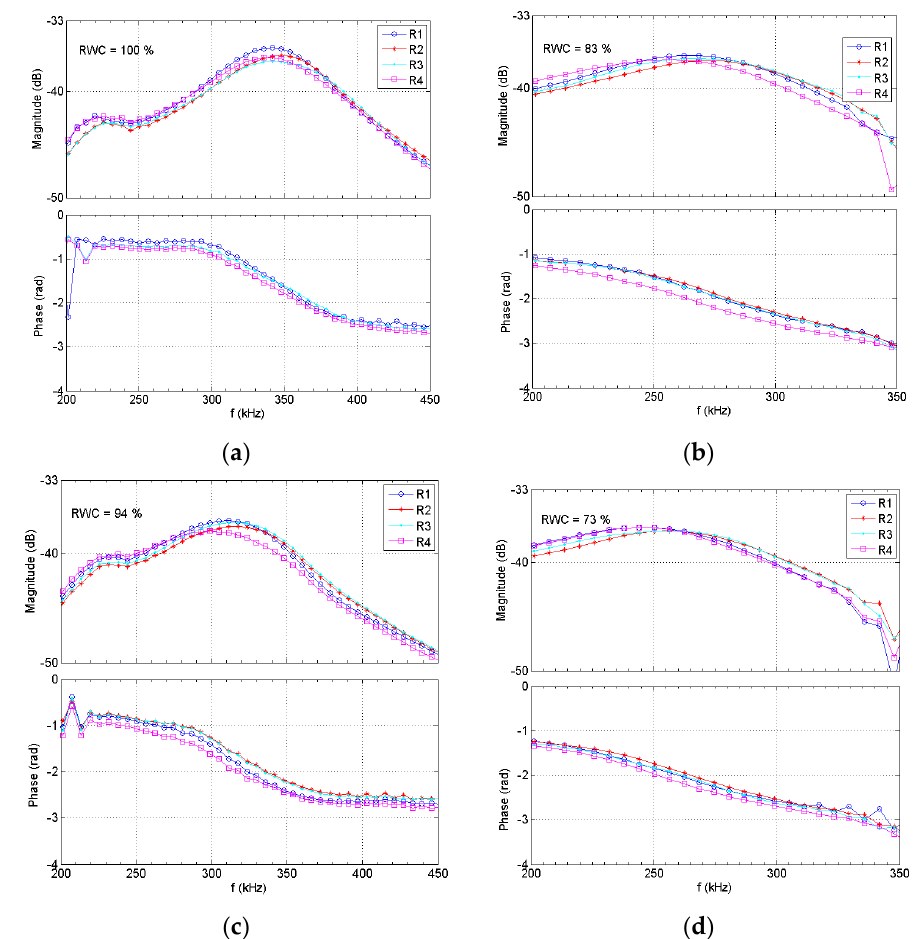
Figure 14. Measured spectra in a Coffea arabica leaf at four different positions (R1, R2, R3 and R4) and at four different RWC values (100%, 94%, 83% and 73%). ( a ) RWC = 100%; ( b ) RWC = 83%; ( c ) RWC = 94%; ( d ) RWC = 73%.